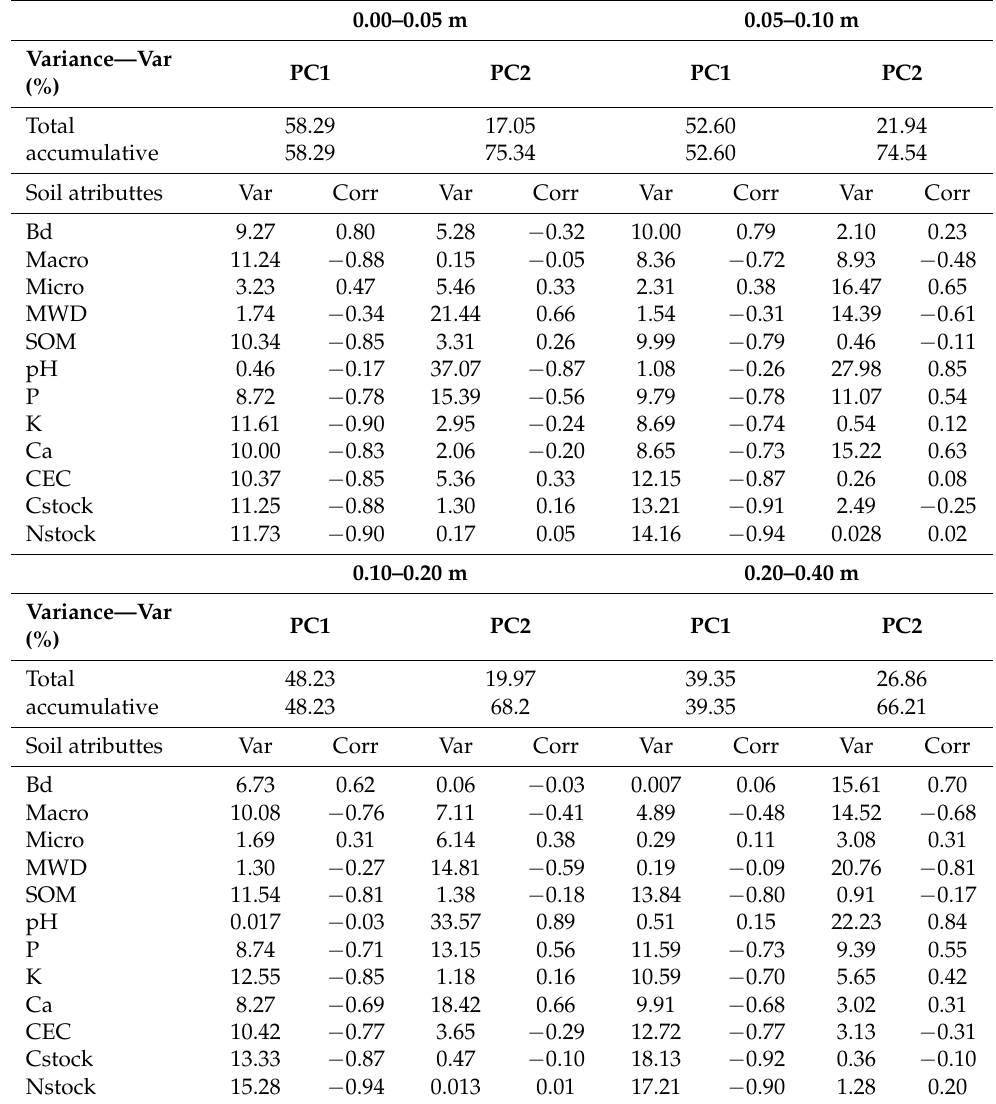
Table 3. Variance data of the principal components PC1 and PC2 with correlation of the physical and chemical soil